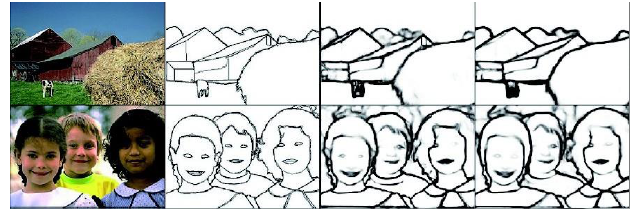
Figure 10. Comparison of output images of CFF and RCF at each stage. From fist row to fifth row: stage1-stage5. From fist column to fifth column: RCF (airplane), proposed (airplane), RCF (wapiti), proposed (wapiti). Figure 9. Comparison of the results of proposed and RCF